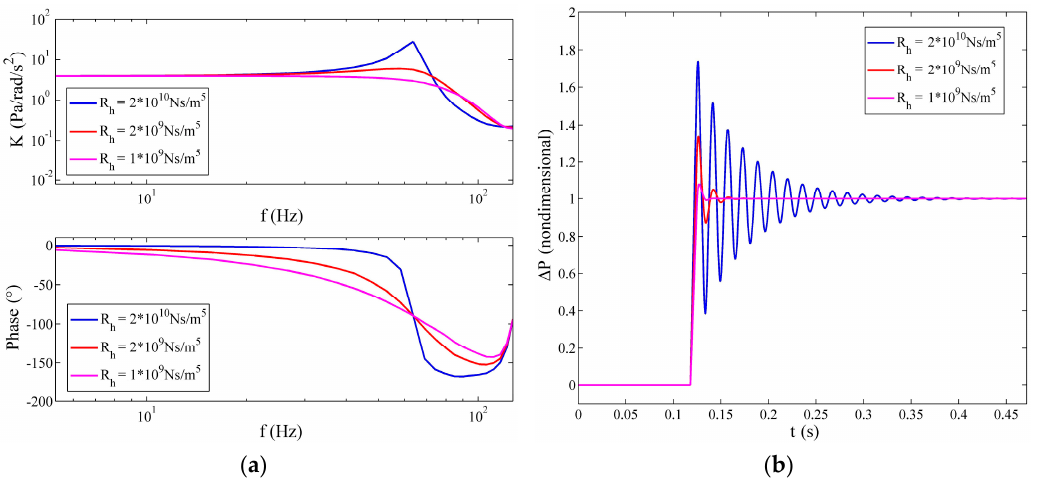
Figure 15. Changes of the frequency response and transient response resulting from R h variation, where a = 20 m/s, R = 25 mm, r = 4 mm. ( a ) Variation of the frequency response; ( b ) variation of the step response.